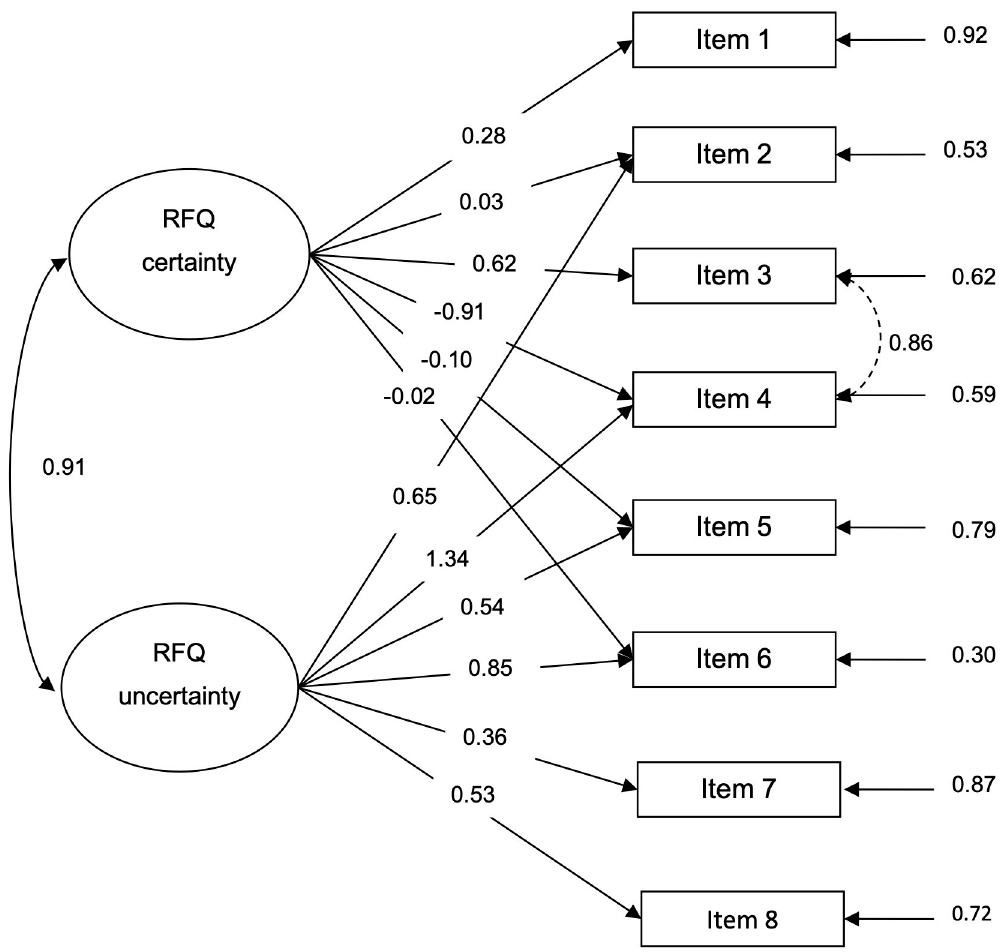
Fig 2. Confirmatory factor analysis for the two-factor structure in the non-clinical sample. Note: The standardized factor loadings, error variances and covariance among exogenous variables are shown. As in Spitzer et al. [28], and Mu¨ller et al [29] studies, the error of items 3 and 4 were allowed to